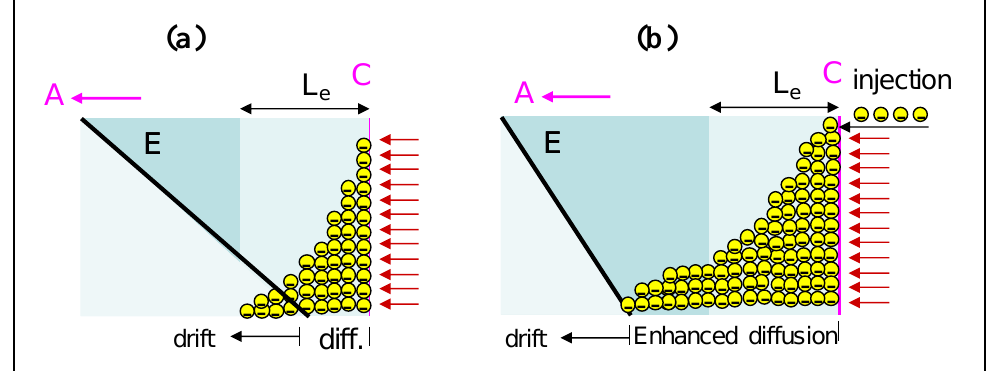
Figure 10. Sketch of transient effects near the irradiated cathode (highly absorbed radiation). In ( a ) the electric field is still close to the cathode and it is recoiling towards the anode (the current tends to decrease). In ( b ) the field has recoiled more than the L from the cathode and electron injection from cathode occurs causing enhanced diffusion (the current tends to increase and then to